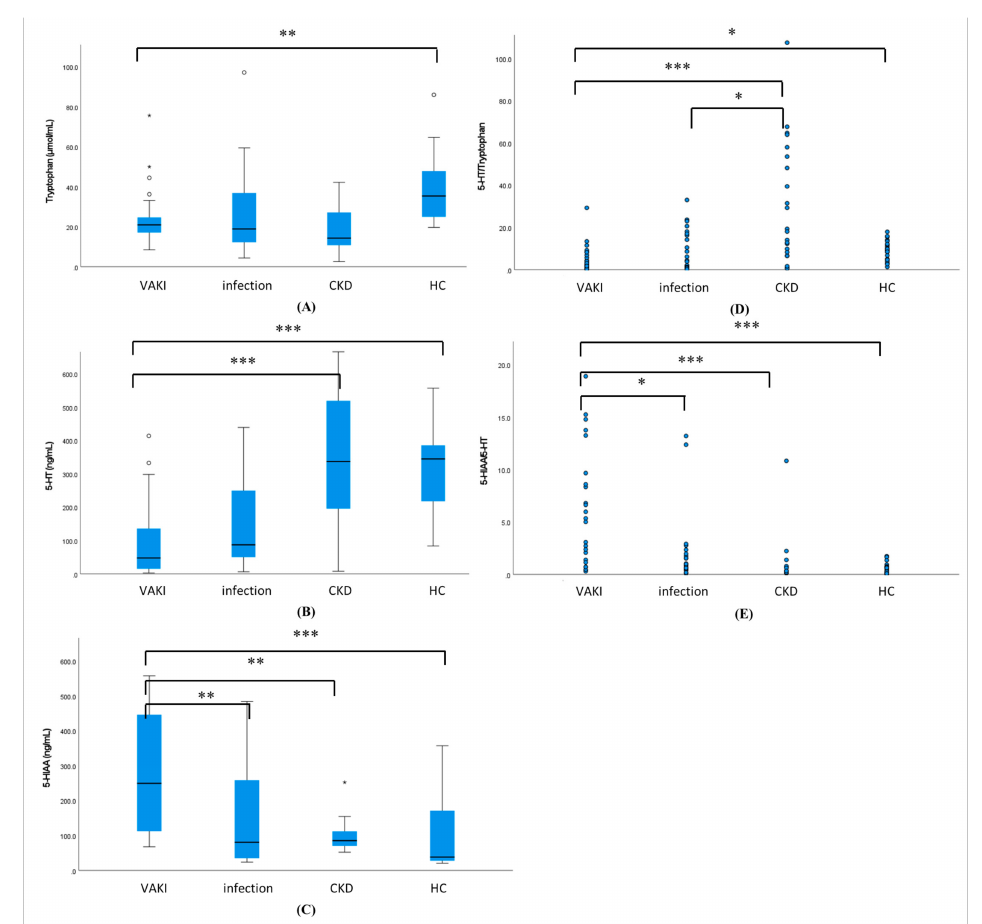
Figure 3. Comparison of serum concentration of tryptophan, 5-HT, 5-HIAA, and the ratio of 5-HT to tryptophan (5-HT/Trp) and 5-HIAA to 5-HT (5-HIAA/5-HT) between the VAKI group and non-VAKI subgroup. Notes: ( A ) Serum concentration of tryptophan ( µ mol/mL); ( B ) Serum concentration of 5-HT (ng/mL); ( C ) Serum concentration of 5-HIAA (ng/mL); ( D ) the ratio of 5-HT to tryptophan (5-HT/Trp); and ( E ) the ratio of 5-HIAA to 5-HT (5-HIAA/5-HT) were compared between the VAKI group and non-VAKI subgroups. Each box represents the interquartile range. Each line inside the boxes is plotted at the median. Each whisker means the 10th and 90th percentiles. * p < 0.5, ** p < 0.01, *** p < 0.001, respectively. Abbreviations: VAKI, vancomycin-associated acute kidney injury; CKD, chronic kidney disease; HC, healthy control; 5-HT, serotonin; 5-HIAA, 5-hydroxyindoleacetic acid; 5-HT/Trp, the ratio of serotonin to tryptophan; 5-HIAA/5-HT, the ratio